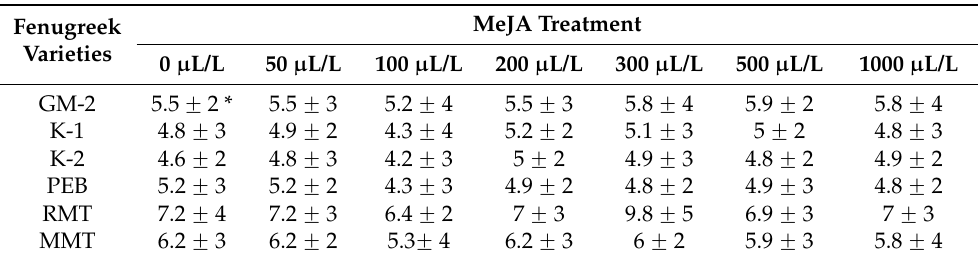
Table 4. Effect of methyl jasmonate (MeJA) treatments on the fresh weight (mg) of seedlings of different fenugreek ( Trigonella foeum-graecum L.) varieties. Fenugreek Varieties